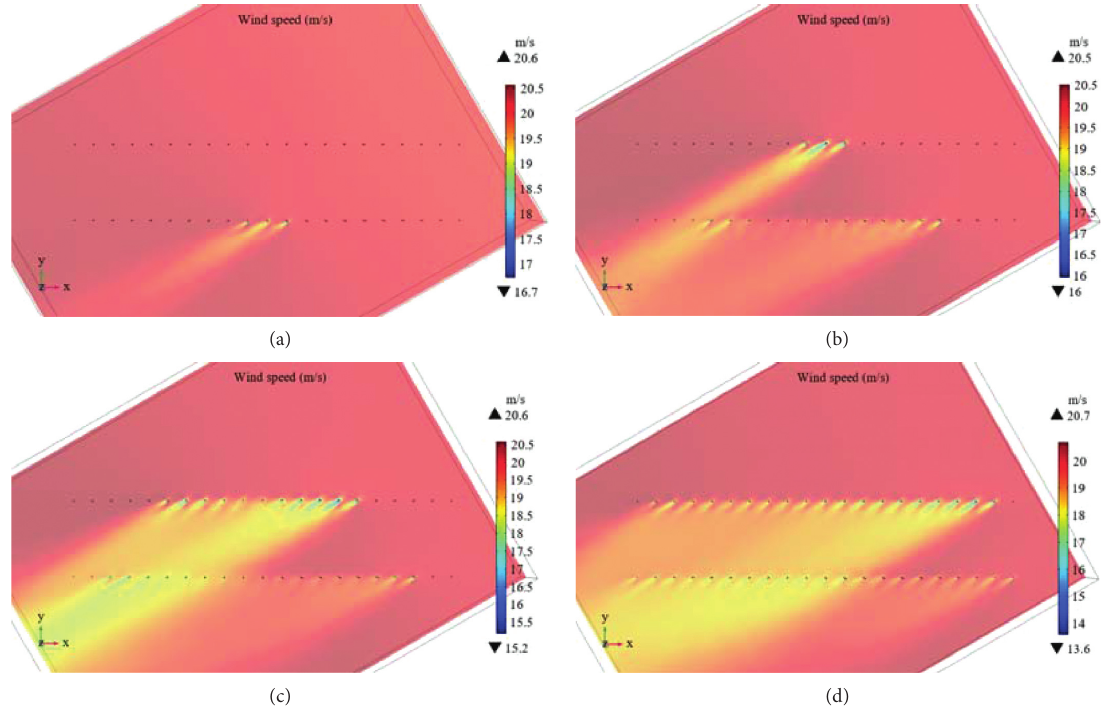
Figure 13: Influence of height for wind field (wind direction � 240 ° /300 ° ). (a) 240 ° /300 ° , z � 10m. (b) 240 ° /300 ° , z � 5 m. (c) 240 ° /300 ° , z � 3m. (d) 240 ° /300 ° , z �